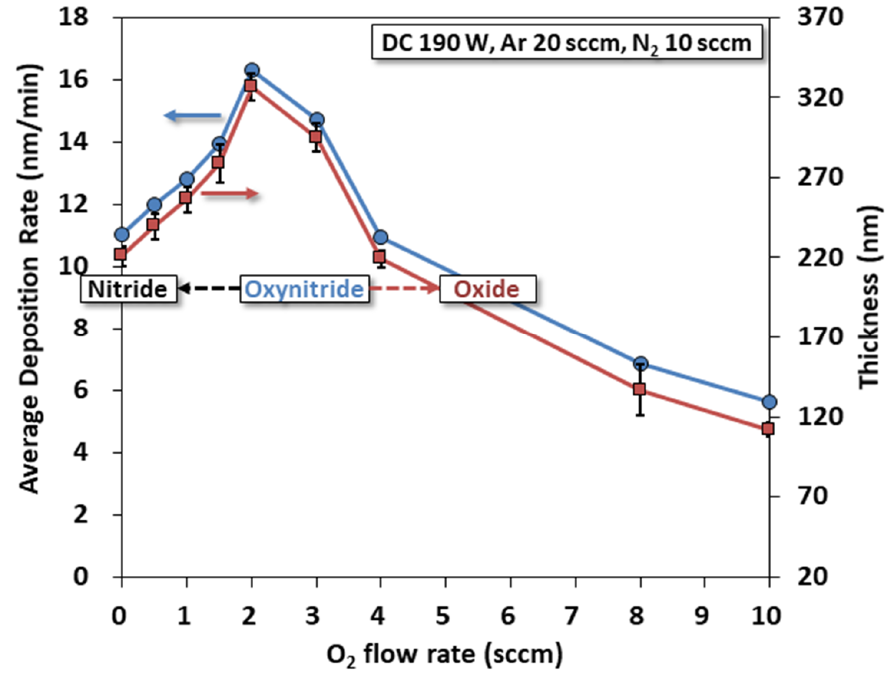
Figure 2. The average deposition rate and thickness of deposited